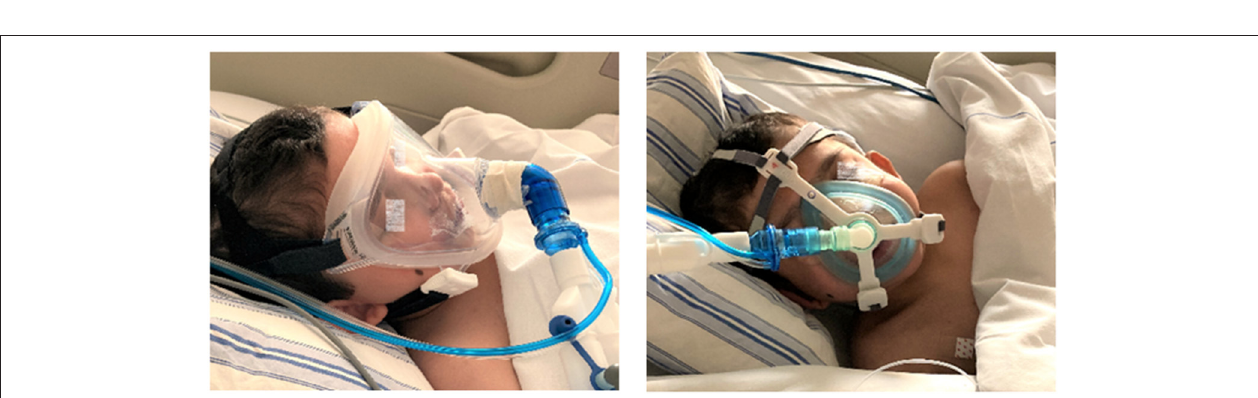
FIGURE 2 | NIV interface application in the child. NIV provided by a total face mask (left panel) and by a simple anesthetic mask using an in-house 3D printed adaptor for connection to a five-point head gear (right panel). Photographs taken and printed with permission granted by the